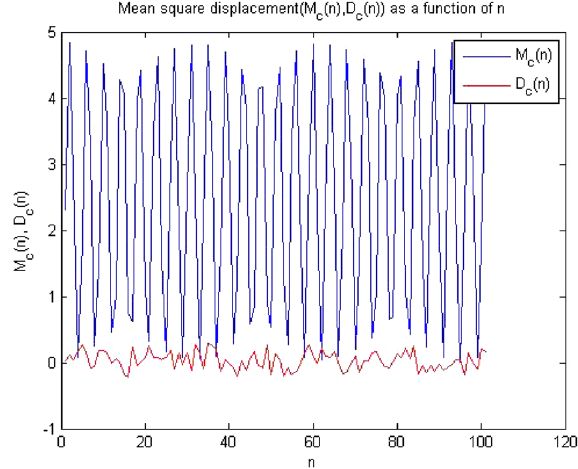
Figure 9. Plot of MSD vs time corresponding to periodic dynamics.